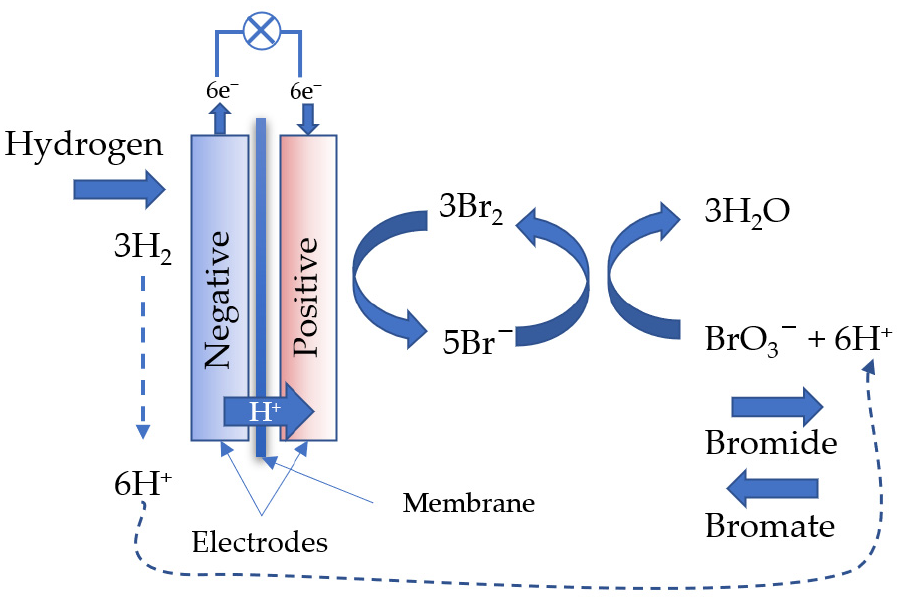
Figure 3. The overall principle of the hydrogen − bromate flow battery operation based on the EC” reaction mechanism.